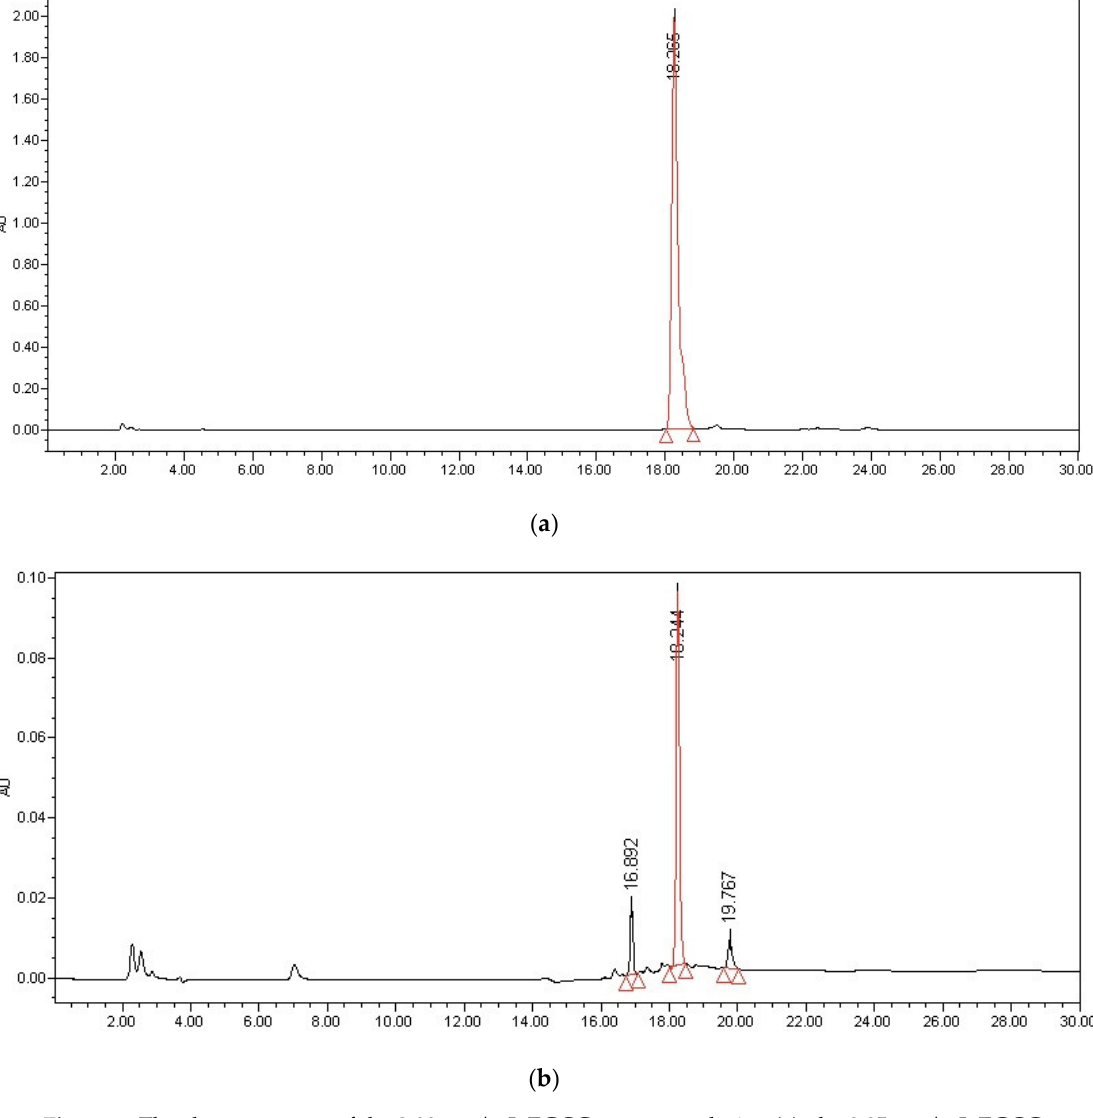
Figure 1. The chromatogram of the 2.00 mg/mL EGCG aqueous solution ( a ), the 0.05 mg/mL EGCG aqueous solution stored without sunlight and air at room temperature for 6 h ( b ). Table 1. Standard curve, correlation coefficient, linear ranges and lower limit of quantification (LLOQ) of EGCG in